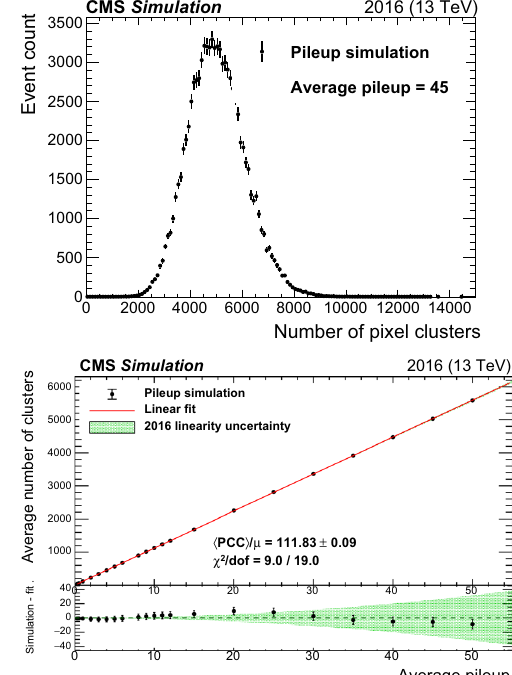
Fig. 2 The upper plot shows the number of pixel clusters and their statistical uncertainty from simulation of pileup following a Poisson distribution with a mean of 45. The lower plot shows the mean number of pixel clusters from simulation as a function of mean pileup. The red curve is a first-order polynomial fit with slope and χ 2 / dof values shown in the legend. Only pixel modules considered for the PCC measurement in data are included. The lower panel of the lower plot shows the dif- ference between the simulation and the linear fit in black points. The green band is the final linearity uncertainty for the 2016 data set